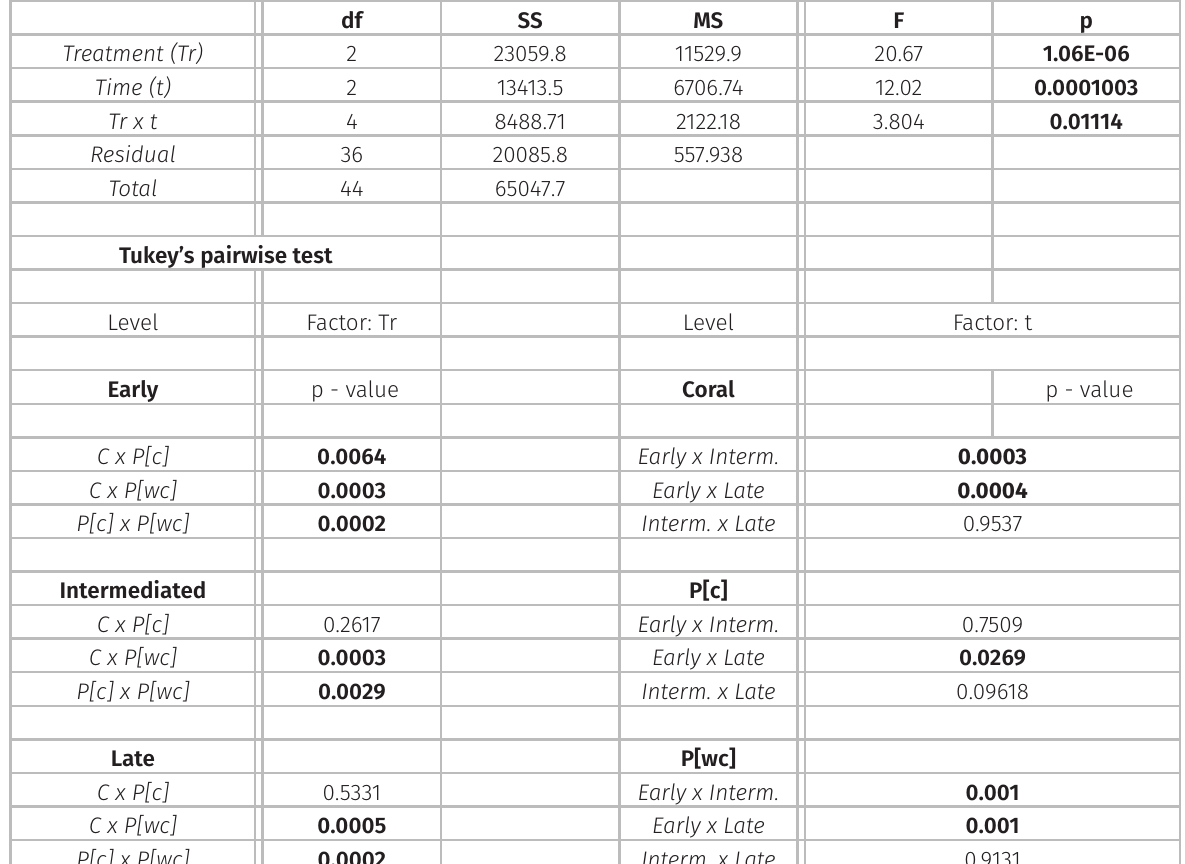
Figure 3. nMDS plot of algal assemblages. Circles, diamonds, and inverted triangles represent the early, intermediate, and late colonisation, respectively. Vectors are based on Pearson correlation coefficients and display the key genera based on a SIMPER analysis that typify certain groupings: (black)algal colonisation directly on dead or damaged coral areas [ Amphiroa (Am), Jania (Ja), Hypnea (Hy)] ;(grey) algal colonisation on recruitment plates in coral-covered areas [ Pneophyllum (Pn), (Ja); Cladophora (Cl), Sphacelaria (Sp)]; and (clear) algal colonisation on recruitment plates in coral- free areas